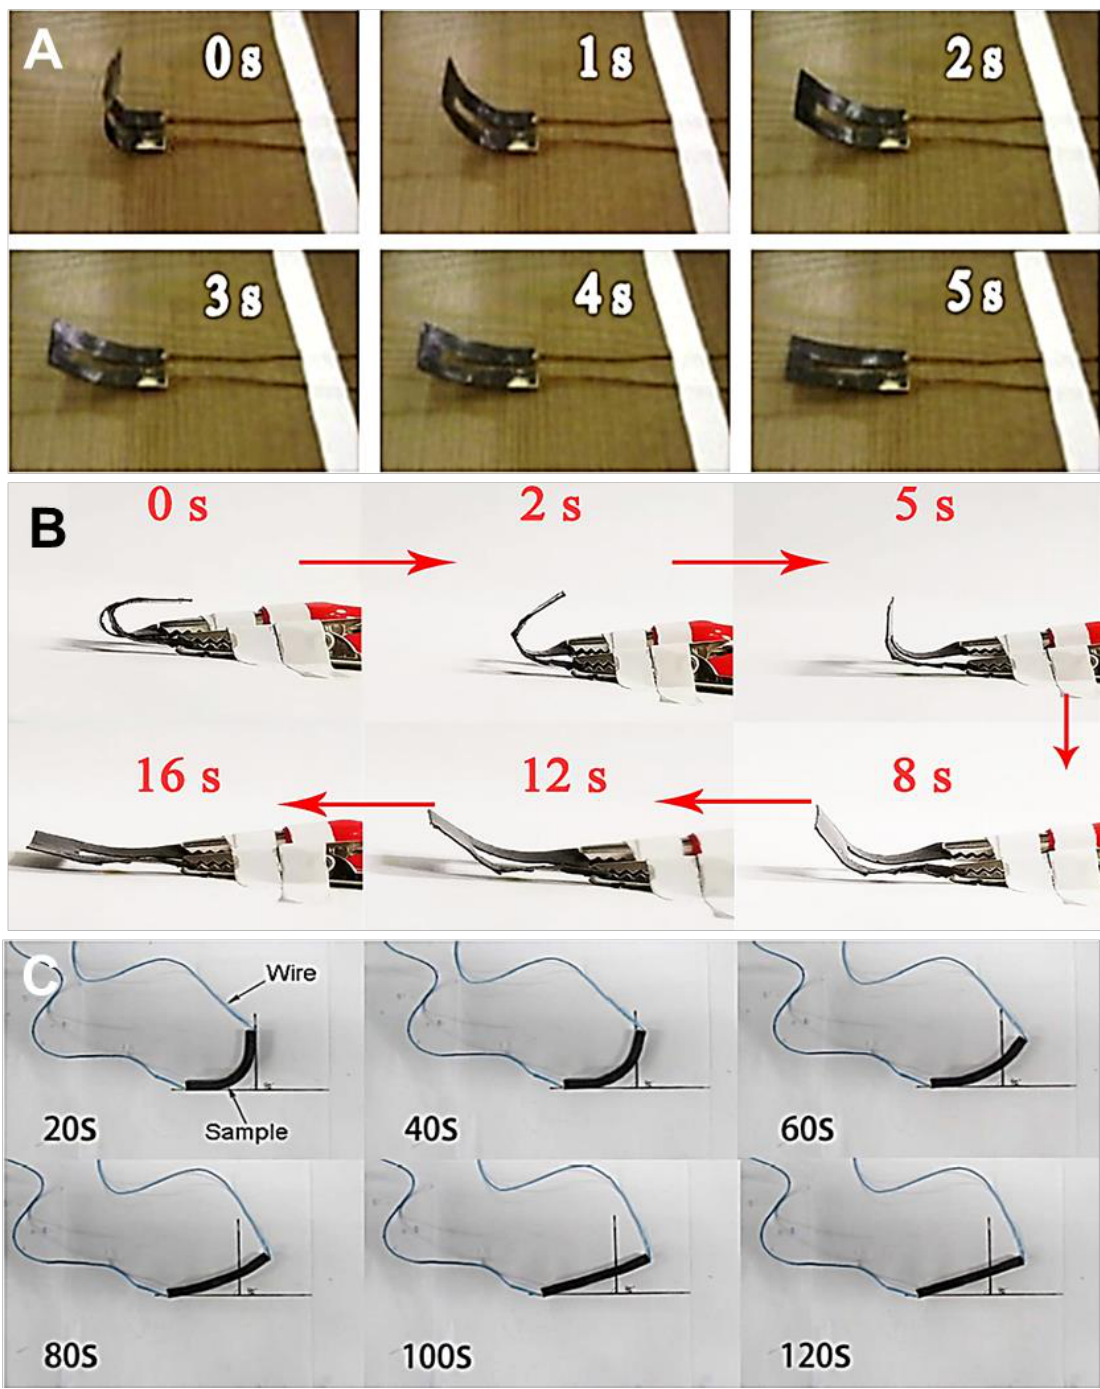
Figure 12. ( A ) Shape recovery process of epoxy/reduced graphene oxide paper-based shape memory nanocomposite under 6 V [122]. Reproduced with permission from Elsevier. ( B ) Electroresponsive shape memory effect of the waterborne epoxy/reduced graphene oxide nanocomposite film at 8 V applied voltage [123]. Reproduced with permission from Elsevier. ( C ) Shape recovery process of the compound aerogel (the weight ratio of carbon nanotubes and graphene is 3:5)/epoxy resin composite under voltage of 60 volts [107]. Reproduced with permission from RSC.